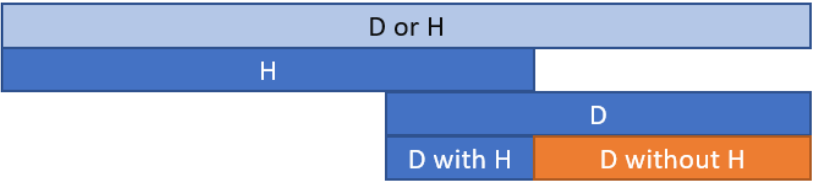
Figure 2. The death calculation method diagram without hospitalization (D without H) is based on the composite endpoint death or hospitalization (D or H). D—death; H—hospitalization. As no raw data is available regarding the mortality and follow-up (time to death), the difference between the death without hospital readmission rates was calculated using a 2 × 2 chi-square test (Supplementary Tables